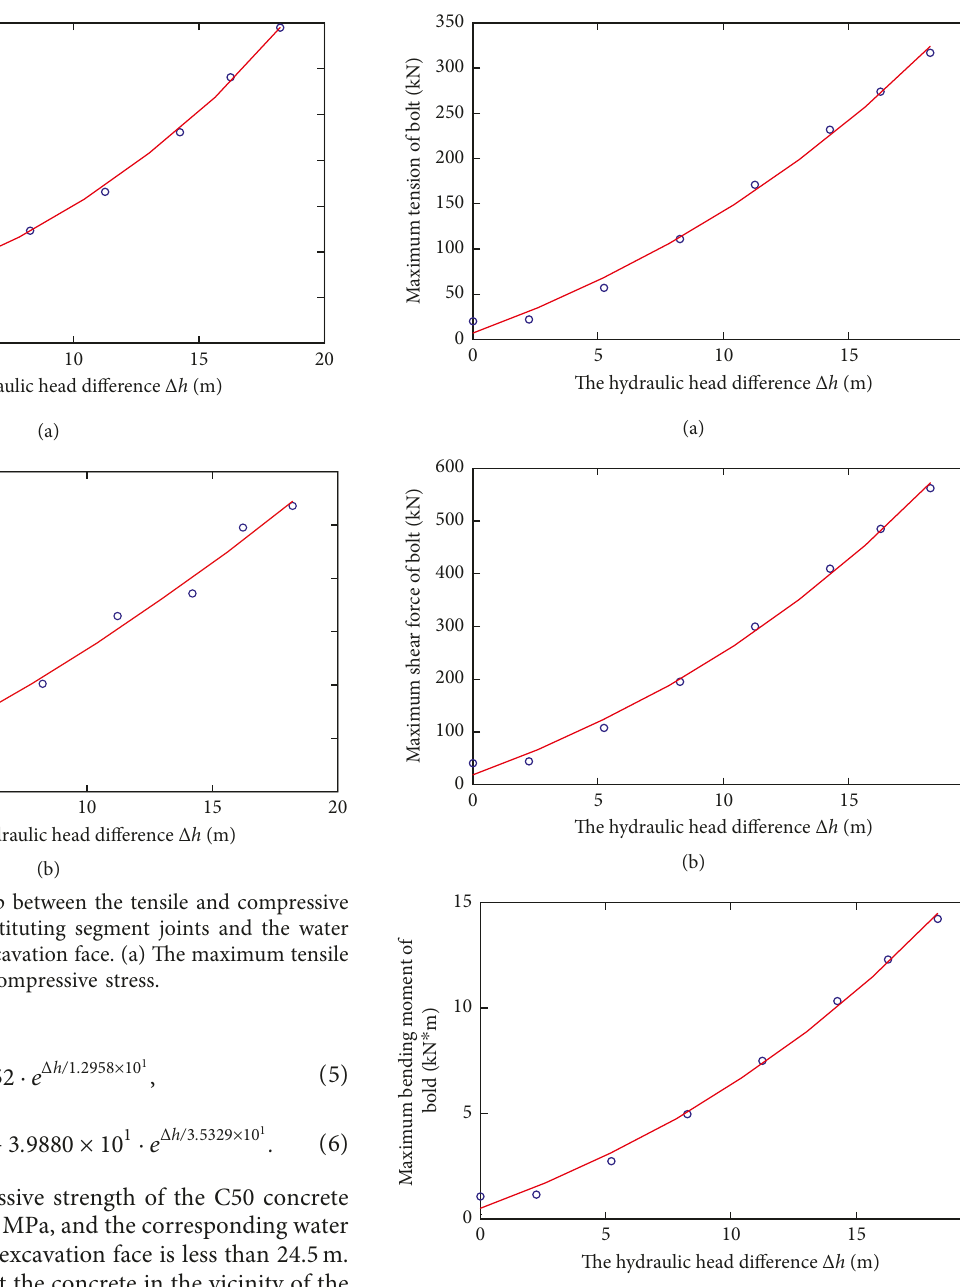
Figure 25: The relationship between the internal force of bolts and the water head difference over the excavation face. (a) The max- imum axial force. (b) The maximum shear force. (c) The maximum bending